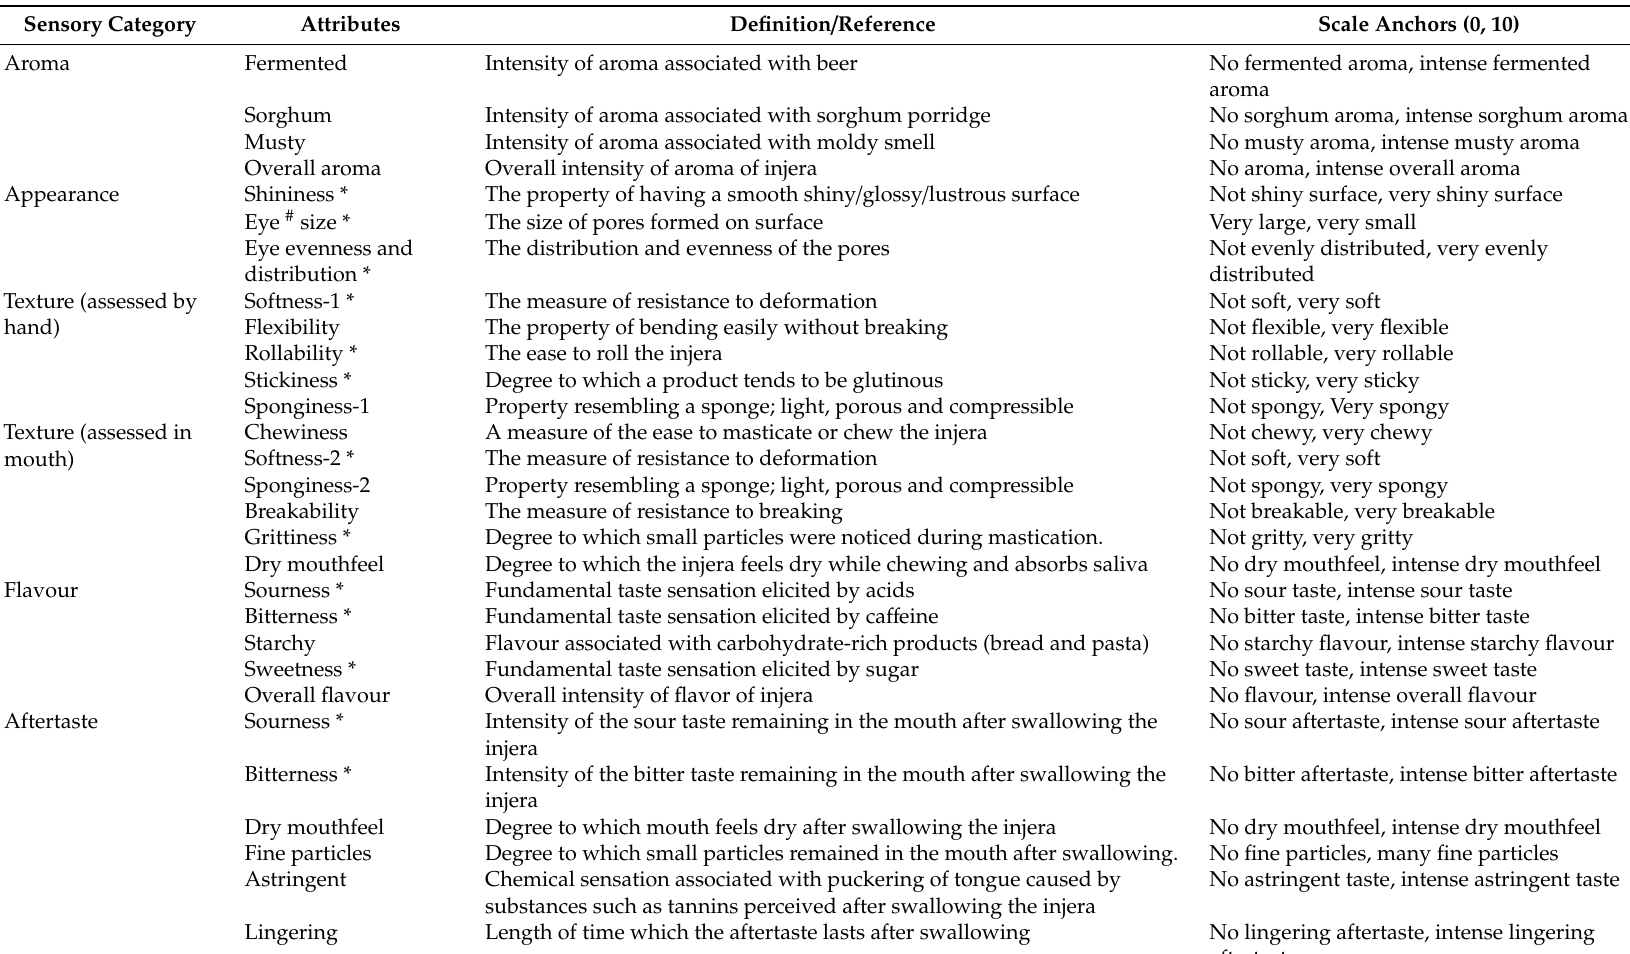
Table 1. Lexicon used to describe the sensory characteristics of injera made from the various sorghum types and te ff